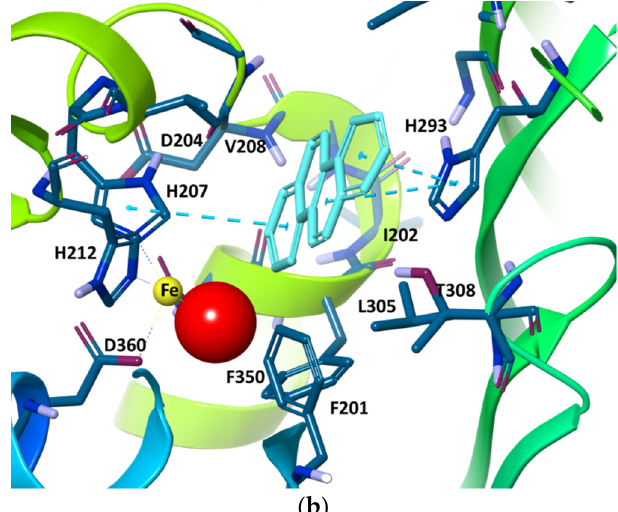
Figure 3. ( a ) Model of naphthalene (orange), anthracene (pink), fluoranthene (green), pyrene (gray), and chrysene (cyan) docked into binding site of biphenyl dioxygenase from Sphingobium yanoikuyae (ID 2gbx), with docking scores of − 5.1, − 7.6, − 6.9, − 7.1, and − 7.6 kcal/mol, respectively (Table S3). Red ball is an oxygen molecule, and dashed cyan lines indicate aromatic staking interaction in the catalytic pocket. ( b ) Model of chrysene docked into substrate pocket.